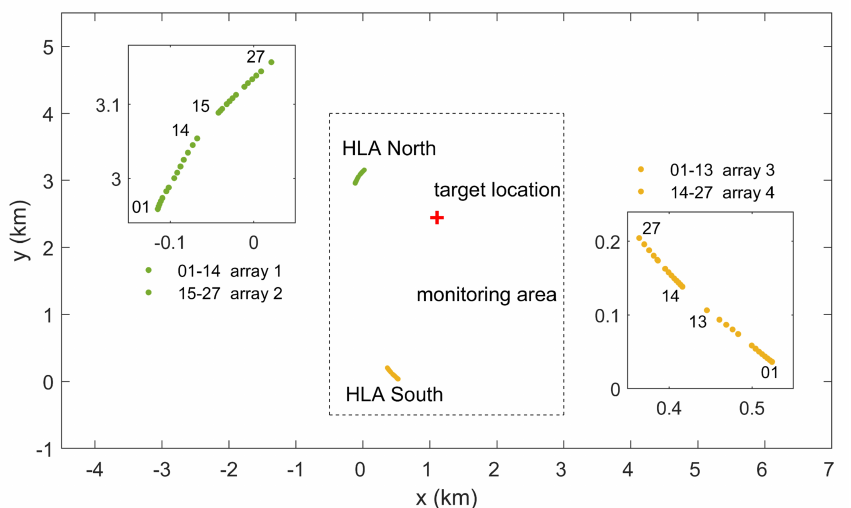
Figure 10. (Color online) Geometric plot of the 27-element subsets of the two horizontal line arrays and the source location to be estimated. Filled green and yellow circles indicate HLA North and HLA South, respectively. The four small-aperture arrays 1 to 4 are indicated by element indices. The red plus mark indicates true source location investigated. The box with dotted lines marks the edge of the monitoring